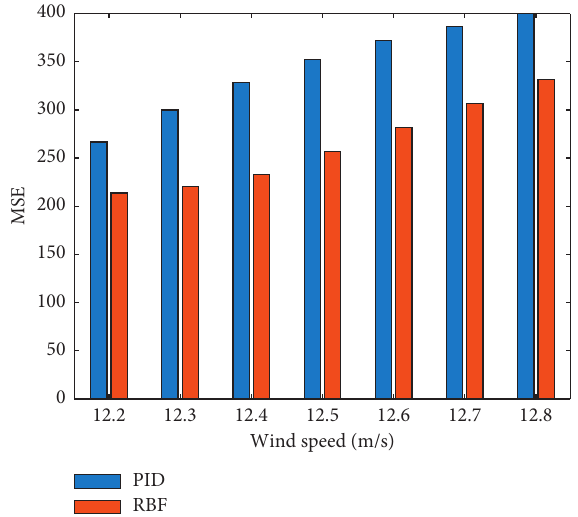
Figure 6: Evolution of MSE with wind